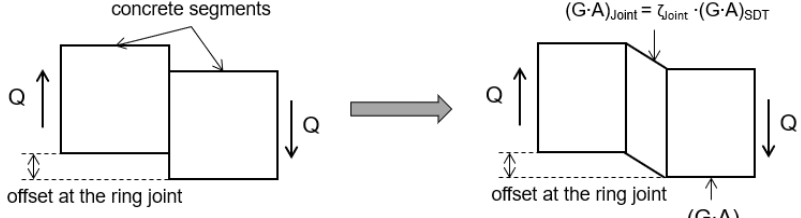
Fig. 8. Modeling approach to account for the ring-joint-induced shear stiffness